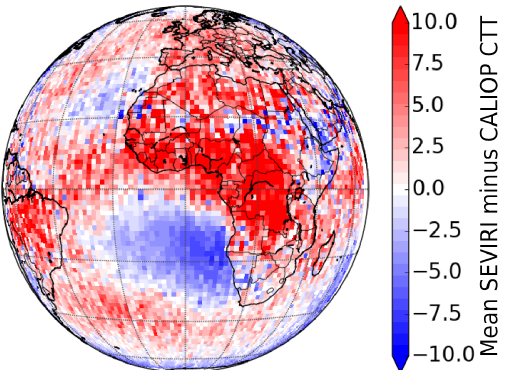
Figure B1. Spatial distribution of mean daytime (13:30LST CALIOP overpass) and night-time (01:30LST CALIOP overpass) bias in SEVIRI cloud top temperature retrievals during 2007. This plot is the same as the “Day and night” plot in Fig. 6 but plotted using the same scale as Figs. 6–15 in Benas et al. (2016) for ease of